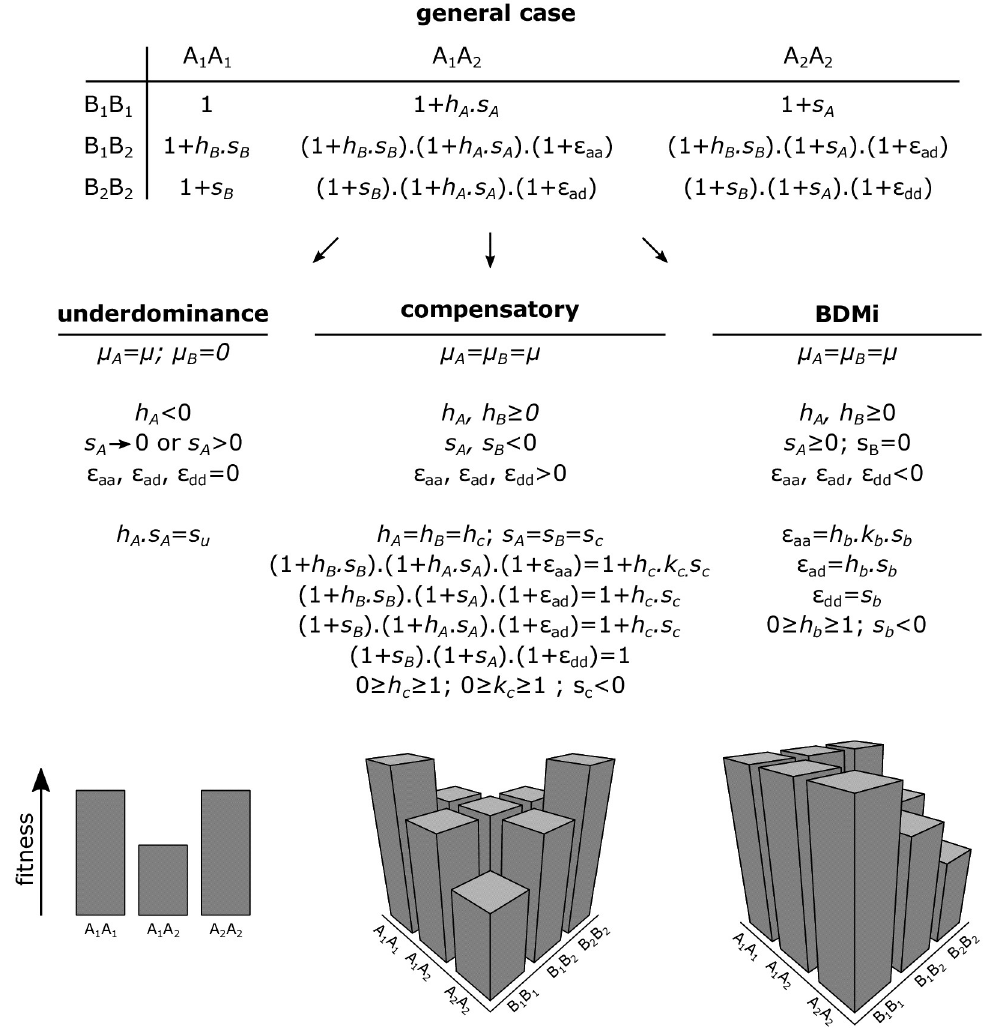
Fig 1. Fitness matrix of a symmetrical general case made of two biallelic loci with dominance coefficients ( h selection coefficients ( s A and s B ), and epistasis coefficients ( � aa , � ad and � dd ). The combinations of value ranges for these parameters explain our three models of genetic incompatibility. The 2D or 3D fitness landscapes represent unique combinations of